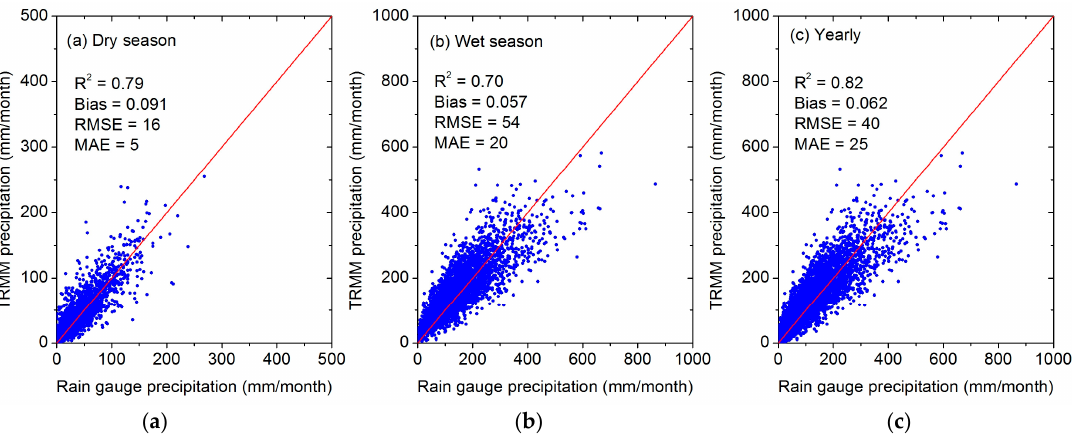
Figure 5. Comparison of precipitation measured by RGS with the original TRMM 3B43 data at multi-time scales: ( a ) the dry season; ( b ) the wet season; and ( c ) the whole year from 2001 to 2015. The red line indicates a 1:1 correspondence.